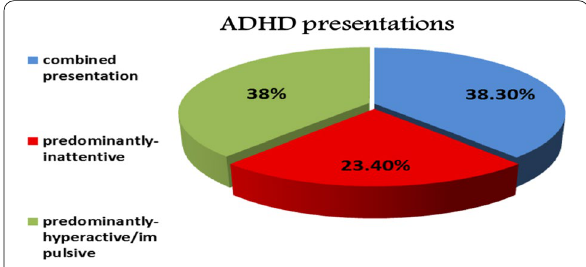
Fig. 1 ADHD presentations according to